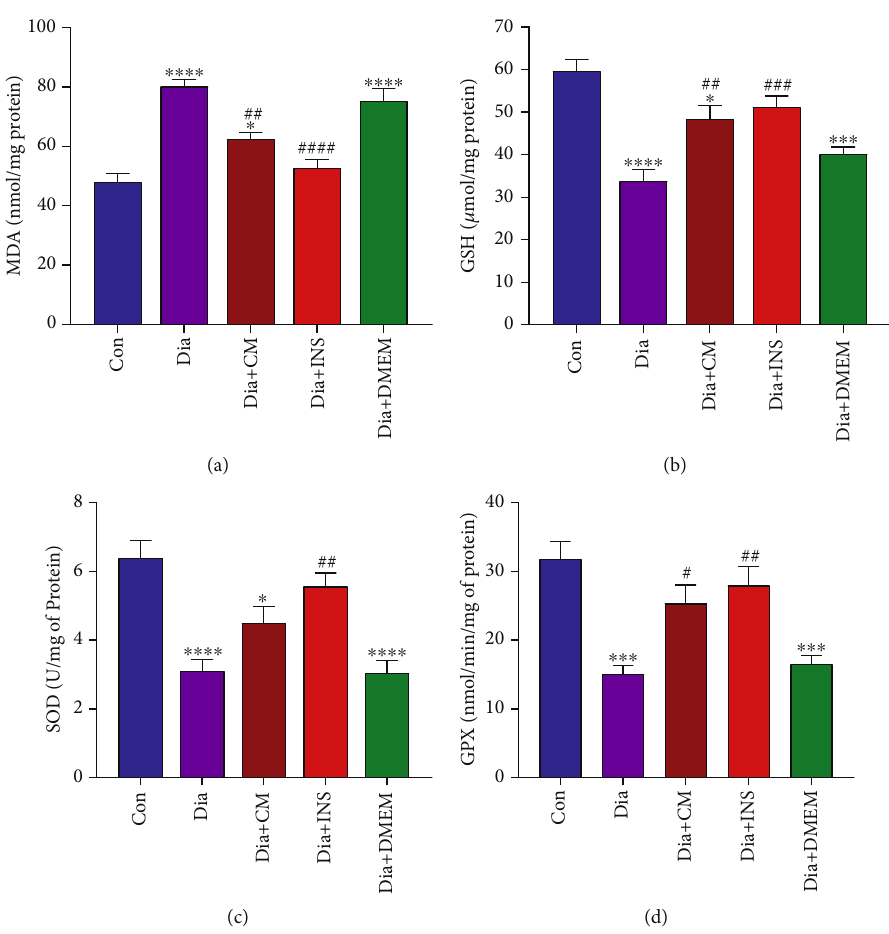
Figure 6: E ff ects of WJMSC-CM and insulin on oxidative stress markers in hippocampus of diabetic rats. According to one-way ANOVA (post hoc: Tukey) analysis, administration of WJMSC-CM improved the hippocampus levels of MDA and GSH, as well as the activity of GPx in diabetic rats. Insulin restores all oxidative stress parameters to normal value. The values are presented as mean ± SEM ( n = 6 ). Signi fi cant di ff erences versus the control ( ∗ P < 0 : 05 , ∗∗∗ P < 0 : 001 , ∗∗∗∗ P < 0 : 0001 ) and diabetes rats ( # P < 0 : 05 , ## P < 0 : 01 , ### P < 0 : 001 , #### P < 0 : 0001 ). Con: control; Dia: diabetes; Dia +CM: WJMSC-CM-treated diabetic group; Dia +INS: insulin-treated diabetic group; Dia +DMEM: DMEM-treated diabetic